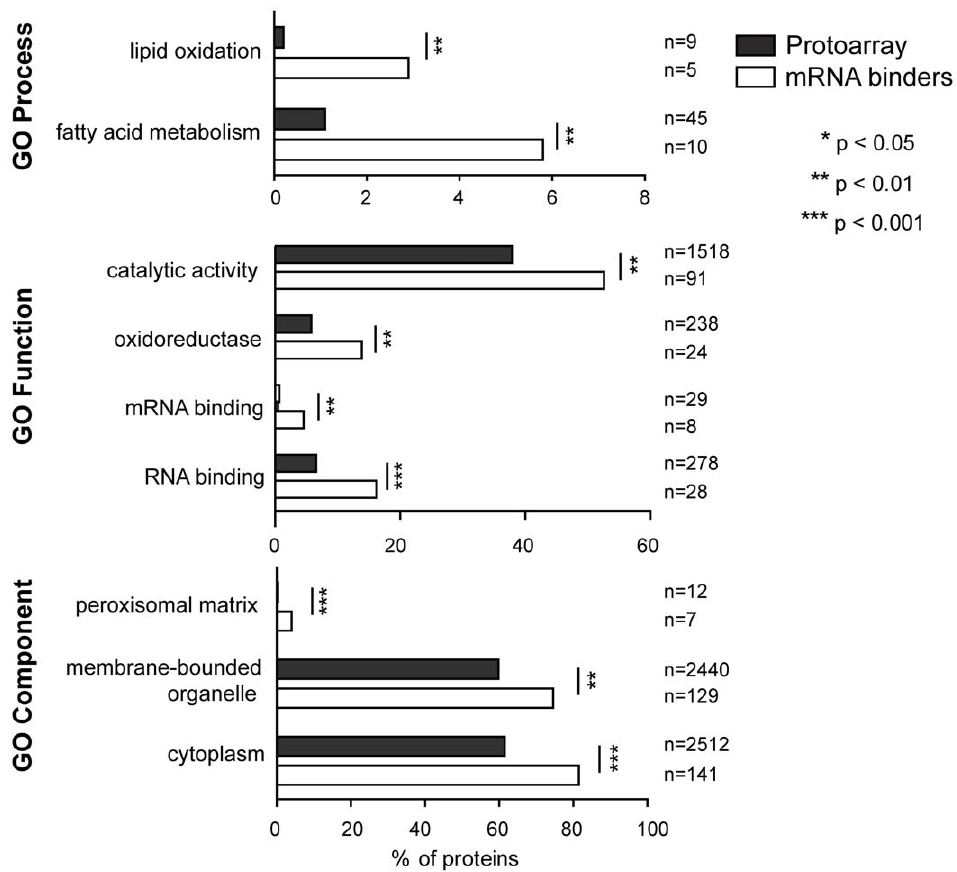
Figure 3. Significantly shared GO terms among mRNA binders. The 173 m RNA binders were searched for significantly enriched GO terms as compared to all the 4,088 proteins present on the protein microarray. Bar diagrams indicate relative amount of genes of the respective GO term among all proteins on the array or among the selected mRNA binders, respectively.